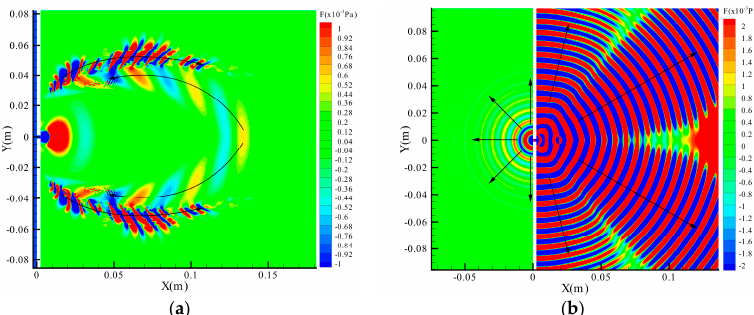
Figure 7. Pressure fluctuation contour of different external environment (The arrow marked in the figure represents the direction of fluctuation wave propagation.). ( a ) vacuum environment; ( b ) atmospheric environment.